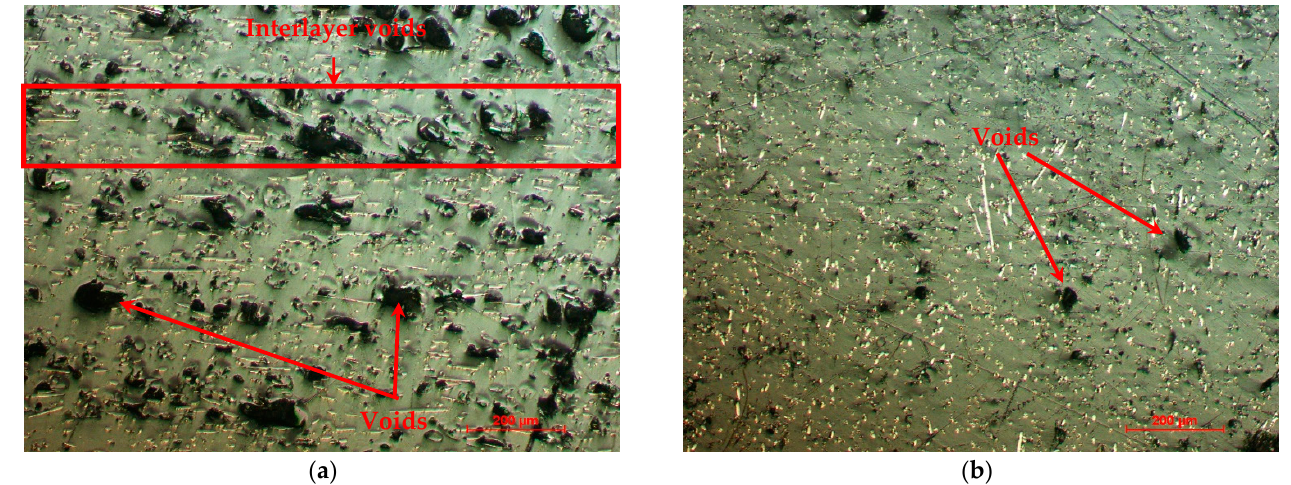
Figure 10. Microscopic analysis of the landing gear fabricated of PET CF15: ( a ) longitudinal section (100×); ( b ) cross-section (100×).